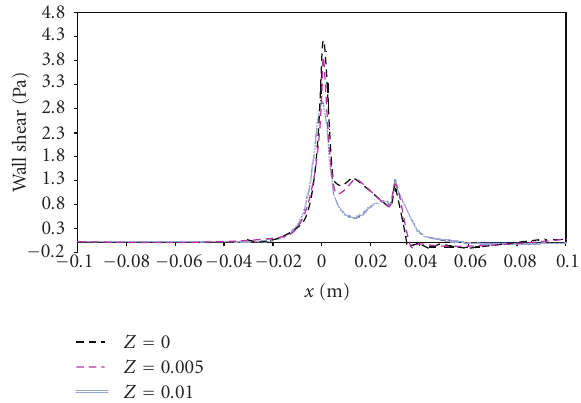
Figure 11: Wall shear profile along several axial planes at the bottom wall (note that elastic wall is located within − 0 . 02136m < x < 0 .